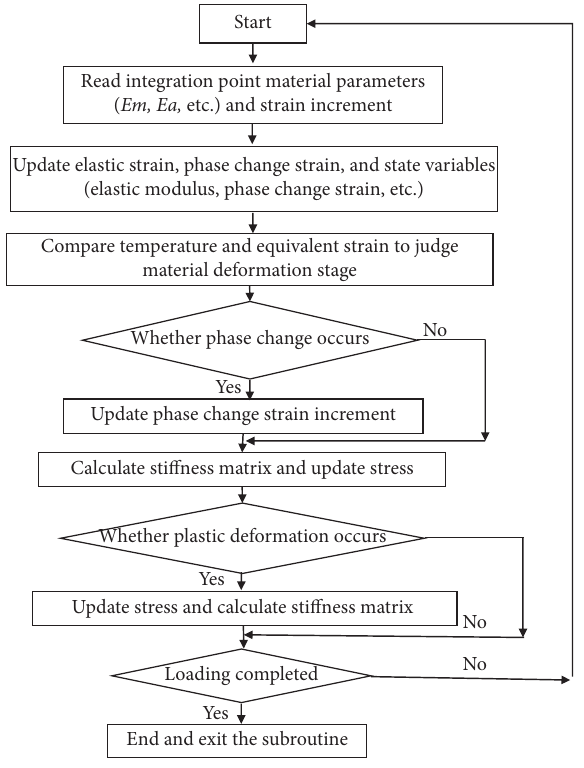
Figure 9: Subroutine flowchart.